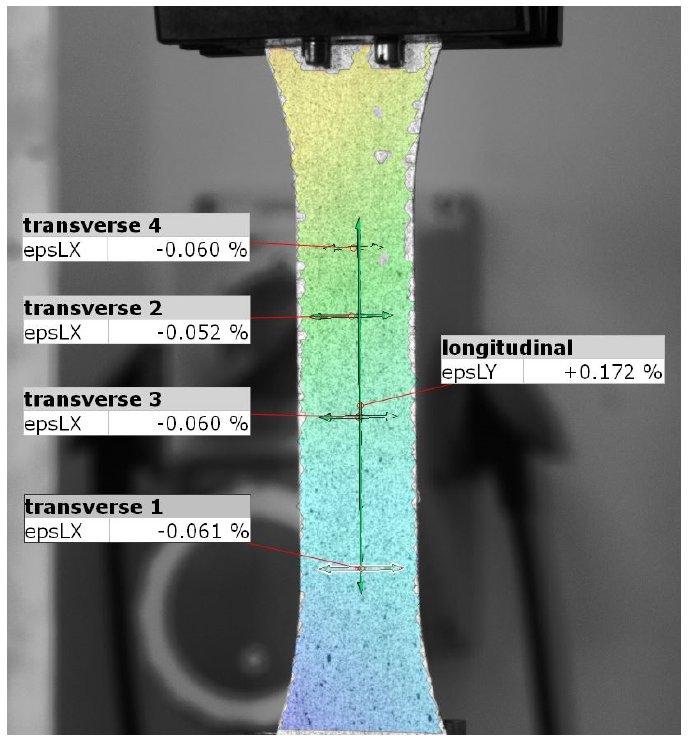
Figure 4. Example of “virtual extensometers” generated with an optical scanner.